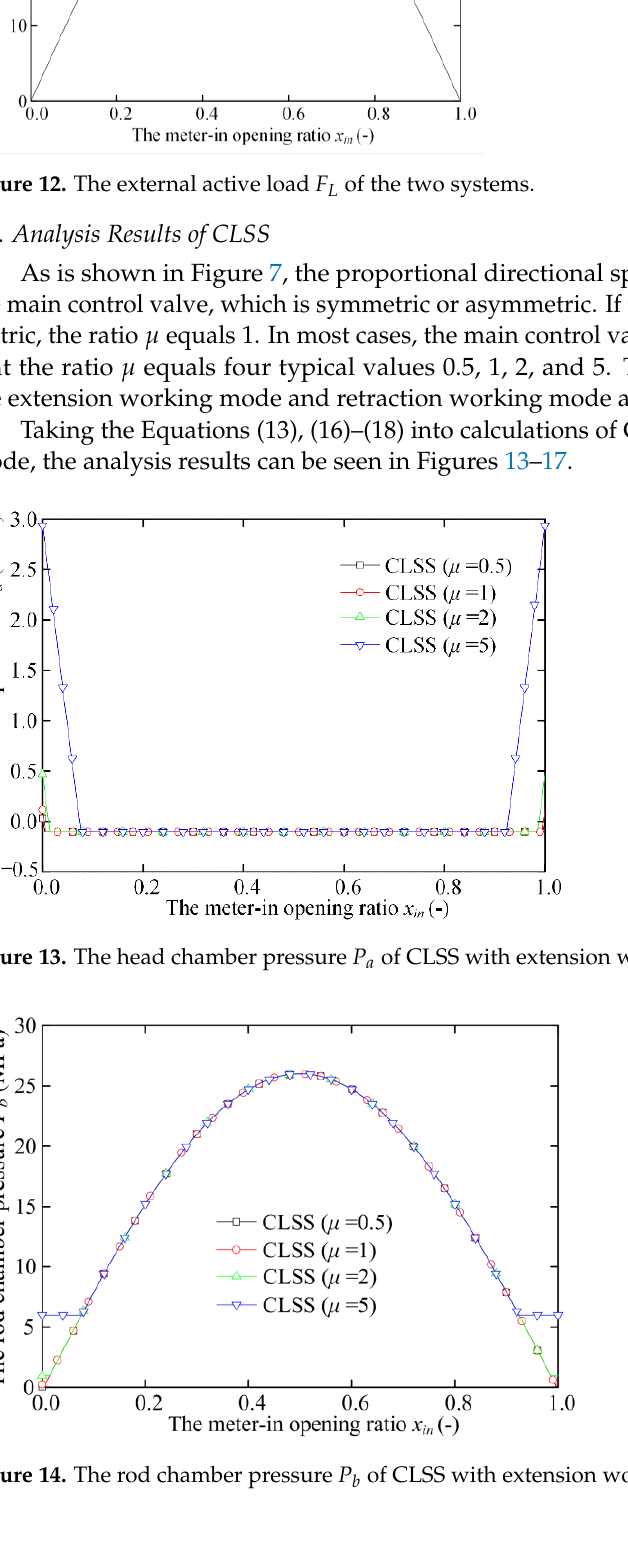
Figure 15. The flow rate Q a of the cylinder head chamber of CLSS with extension working mode.